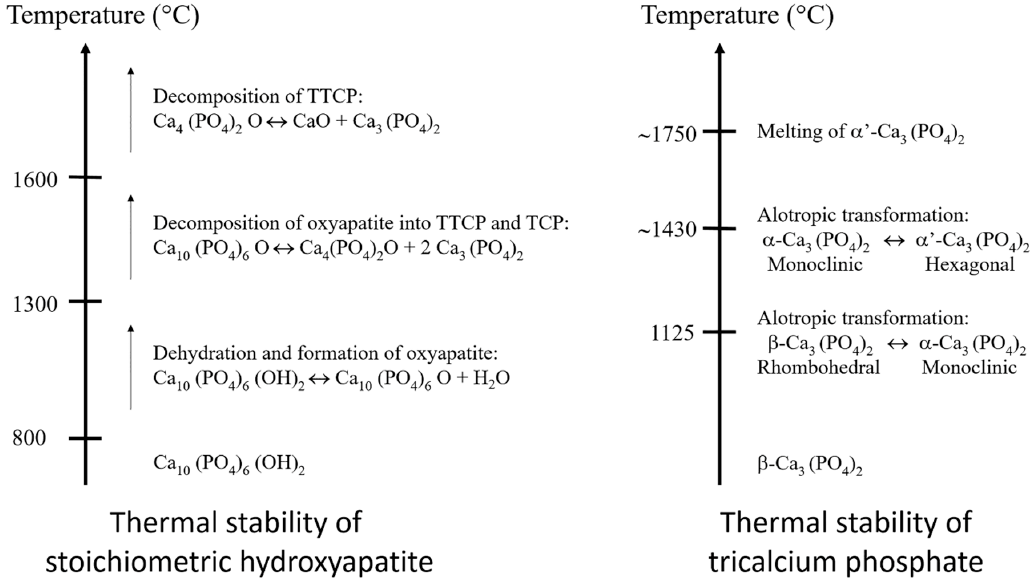
Figure 1. Schematic representation of the thermal stability of stoichiometric hydroxyapatite and crystalline tricalcium phosphate. Data obtained from References [6,7].